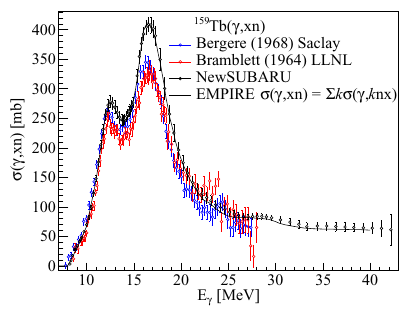
Figure 6. (Color online) The present neutron-yield cross sec- tions, σ ( γ, xn ) for 159 Tb compared with the Livermore [22] and Saclay [23]